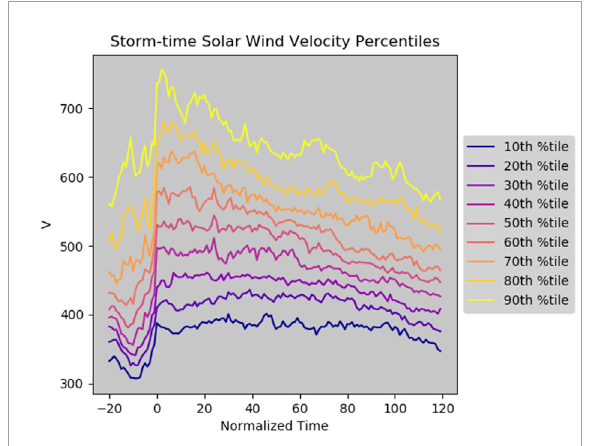
FIGURE 3 Result of the one-dimensional, time-normalised superposed epoch analysis for solar wind speed (V), for data within 168 geomagnetic storms. Deciles are calculated for data between 1992 and 2004. The color indicates the exact decile, referring to the legend plotted on the right.